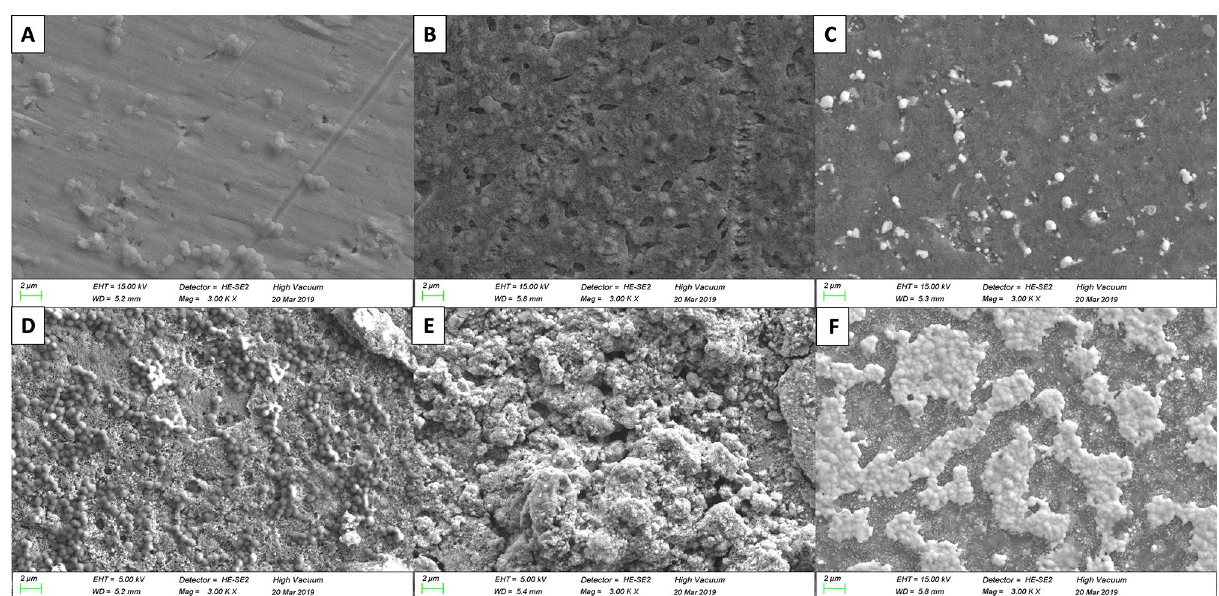
Figure 4. Scanning electron microscope (SEM) images of the discs’ surfaces after 24 h of incubation with S. epidermidis ; ( A ) non-modified control shows several bacterial colonies; ( B ) With the use of Phosphate-doped TiO 2 -nanotubes (pTNT) a trend towards and increased bacterial growth; ( C ) additional selenium-incorporation (SepTNT) lead to significant reduction of bacterial colonies; ( D ) hydroxyapatite-coating (HA) was not capable in reducing bacterial growth; ( E ) in the presence of selenium in combination with HA-coating a distinct reduction of bacteria was detected; ( F ) although distinct bacterial colonies were detected at the surface of silver- selenium incorporated phosphate-doped TiO 2 -nanotubes (Ag 2 SepTNT) most of bacteria was not viable and already ingested silver-selenium particles. Only few single bacterial cells without particle ingestion were